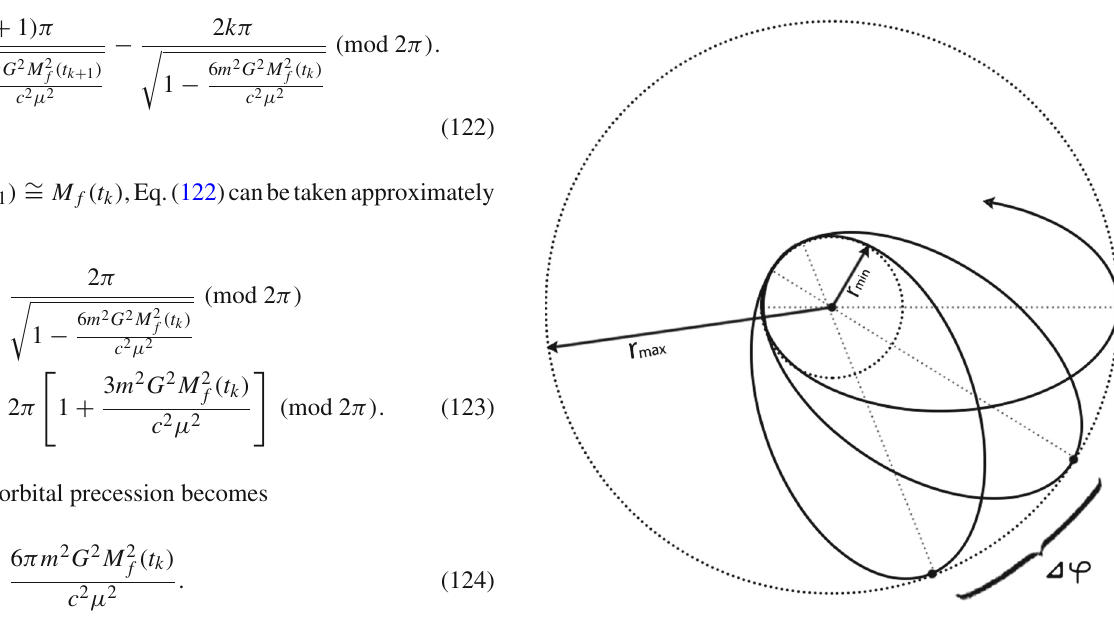
Fig. 1 In a static central field, both r e and Δϕ remain unchanged over time as in Einstein’s theory but have a correction to the corresponding Einstein’s values (illustration following [26])